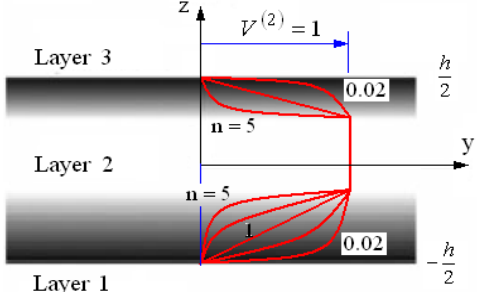
Figure 2. Volume fraction distributions through the thickness of an FG sandwich plate with two FGM facesheets and a homogeneous core (Type A).